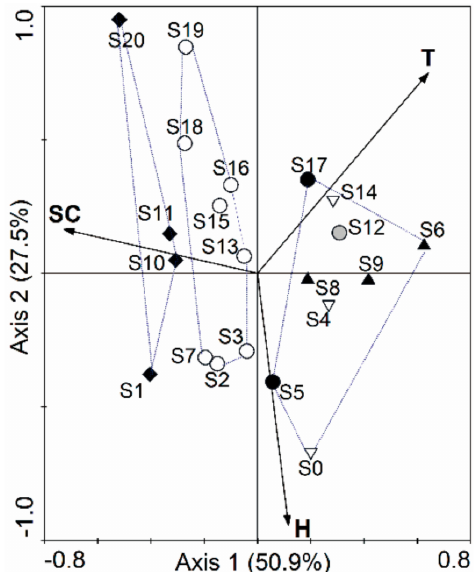
Figure 4. Canonical correspondence analysis (CCA) ordination plots of the Yalutsangpo. H: